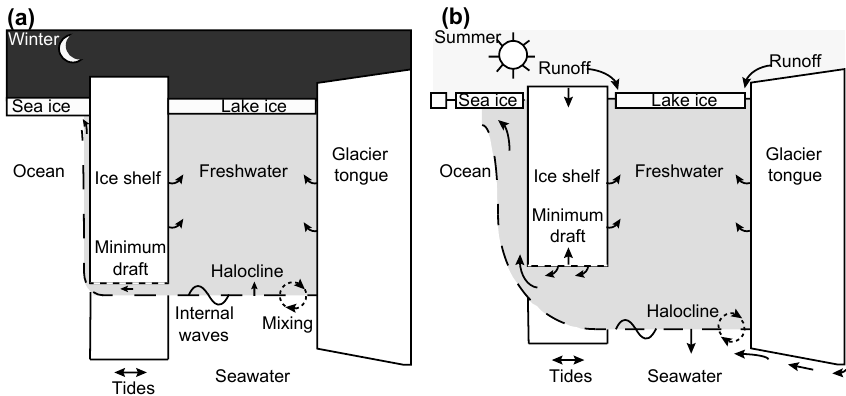
Figure 1. Schematic of the Milne Fiord epishelf lake showing processes that could influence the depth of the halocline in (a) winter and (b) summer. Potential influences include tidal flow, internal waves, mixing, deepening of the freshwater layer due to seasonal inflow, shoaling of the freshwater layer due to outflow beneath the ice shelf, changes in the minimum draft of the ice shelf, or melting along the outflow pathway changing the minimum draft of the ice shelf. Arrows indicating submarine melting of the walls of the ice shelf and glacier tongue and meltwater discharged at the base of the glacier tongue are included for completeness, although neither process will alter the depth of the epishelf lake. The ice walls are in hydrostatic equilibrium, so their melting will add volume to the freshwater layer but not change the depth. Meltwater runoff discharged at the bed of the glacier entrains seawater on its ascent, and observations suggest it spreads out below the epishelf lake halocline as a subsurface plume, which does not contribute to the thickness of the freshwater layer (Hamilton, 2016).